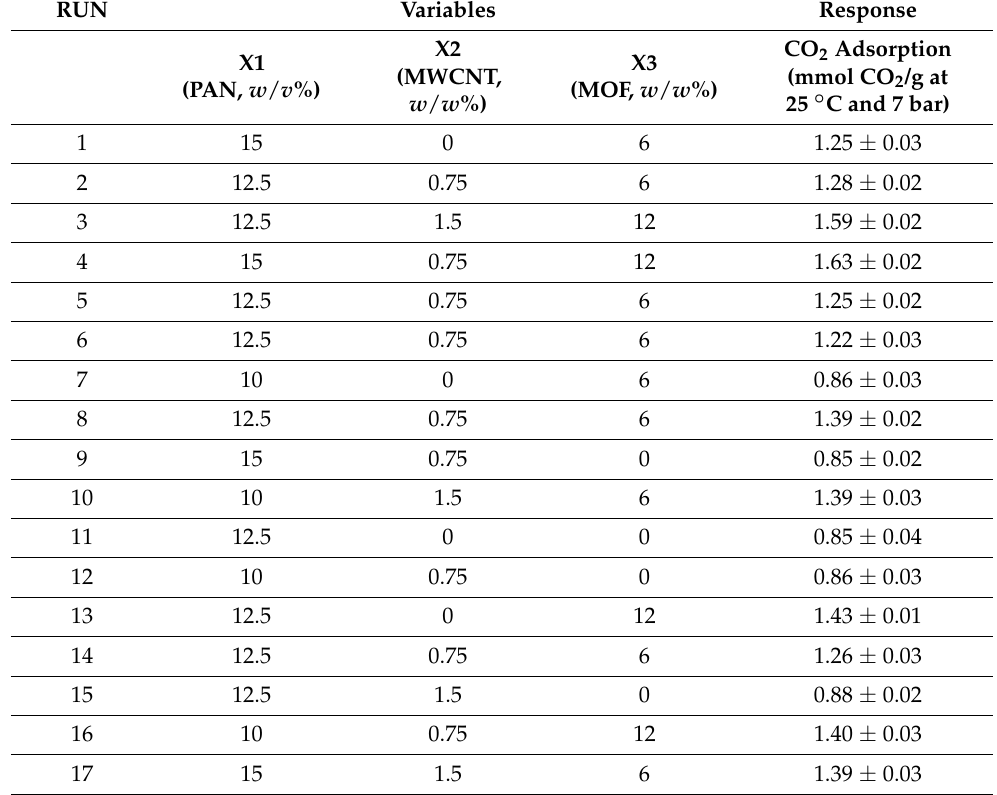
Table 2. Experimental design variables and response.